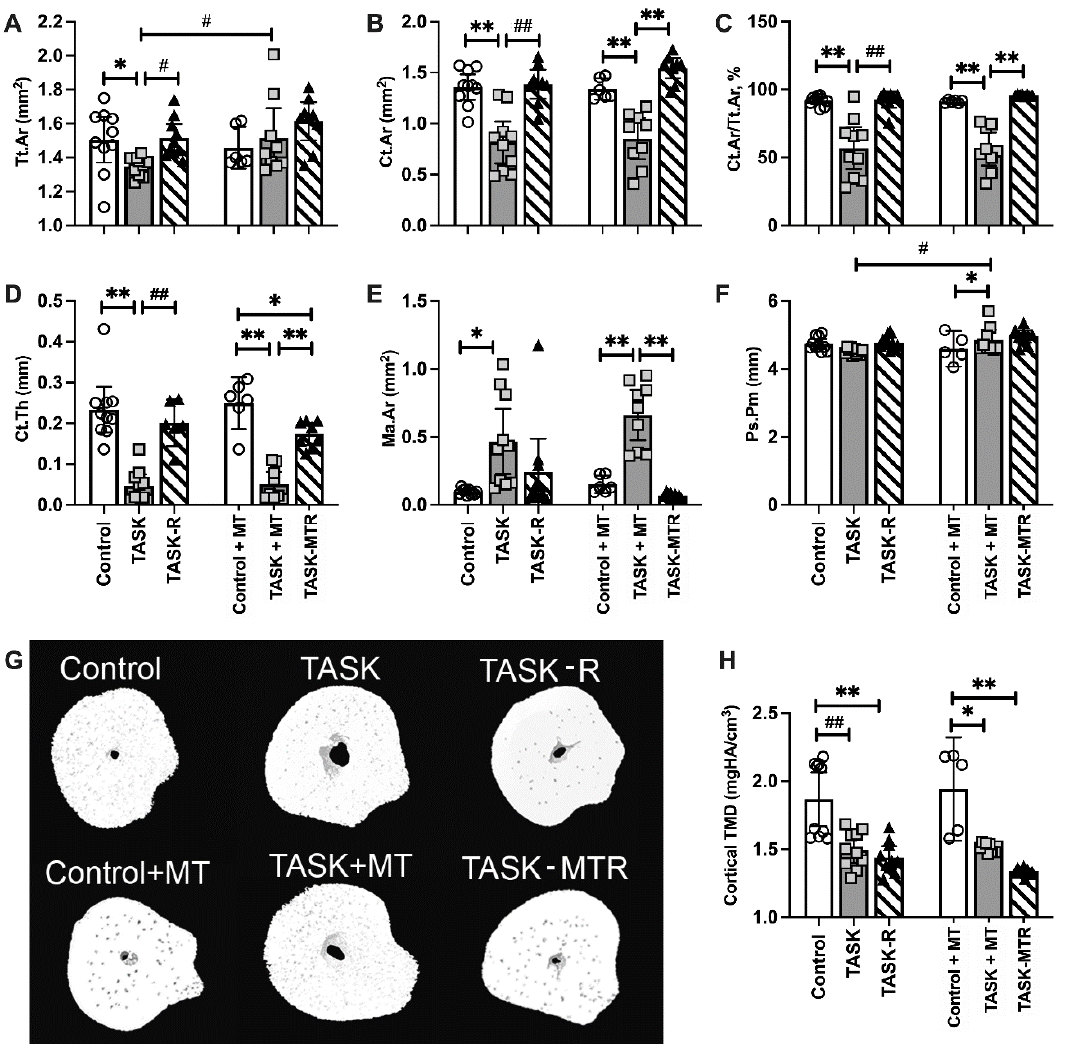
Figure 4. MicroCT of the mid-diaphyseal cortical bone of the radius. ( A – F ) Total area (Tt.Ar), cortical bone area (Ct.Ar), percent cortical area normalized to total area (% Ct.Ar/Tt.Ar), cortical thickness (Ct.Th), marrow area (Ma.Ar), periosteal perimeter (Ps.Pm). ( G ) Representative transaxial images of the mid-diaphysis of the radius. ( H ) Cortical bone tissue mineral density (TMD). Mean ± 95% confidence intervals (CIs) shown. Abbreviations: control rats (Control); 12-week TASK rats (TASK); TASK rats that rested for 6 weeks after task cessation (TASK-R); control rats that received manual therapy for 12 weeks (Control+MT); TASK rats that simultaneously received manual therapy for 12 weeks (TASK+MT); TASK rats that rested for 6 weeks after task cessation while receiving manual therapy treatment of their upper limbs three times per week (TASK-MTR). # and ##: p < 0.05 and p < 0.01, respectively, compared to the TASK group. * and **: p < 0.05 and p < 0.01, respectively, compared between groups as